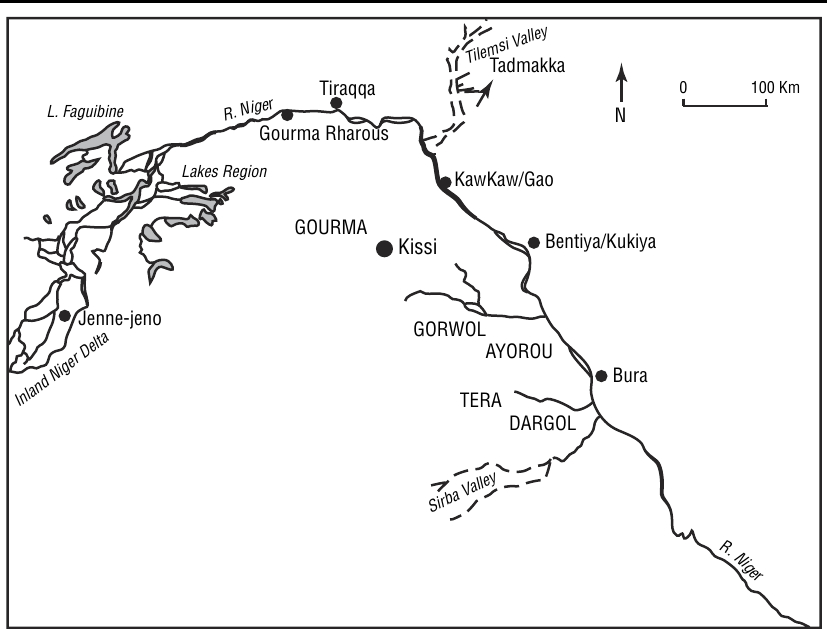
Figure 20 – Towns and districts of the KawKaw/Gao